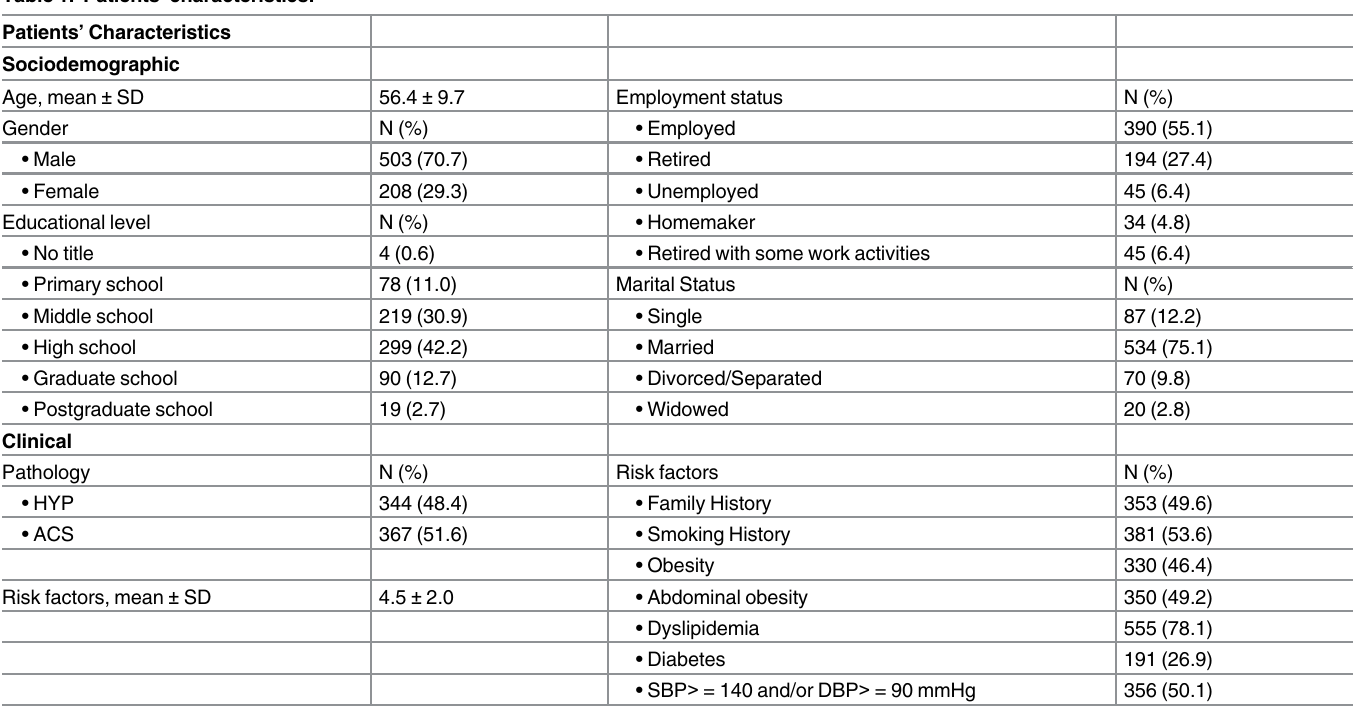
Table 1. Patients ’